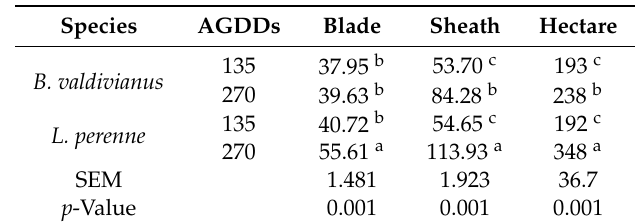
Table 1. Mean water-soluble carbohydrate (WSC) content (kg kg − 1 DM) in leaf sheaths and leaf blades and production per hectare (kg WSC ha − 1 ) for Bromus valdivianus Phil. and Lolium perenne L. defoliated at 135 and 270 accumulated growing degree days